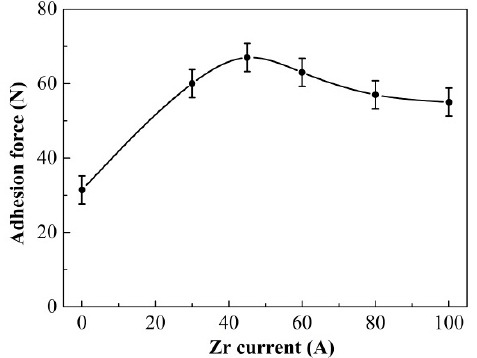
Figure 8. Adhesive force between the coatings and substrate.